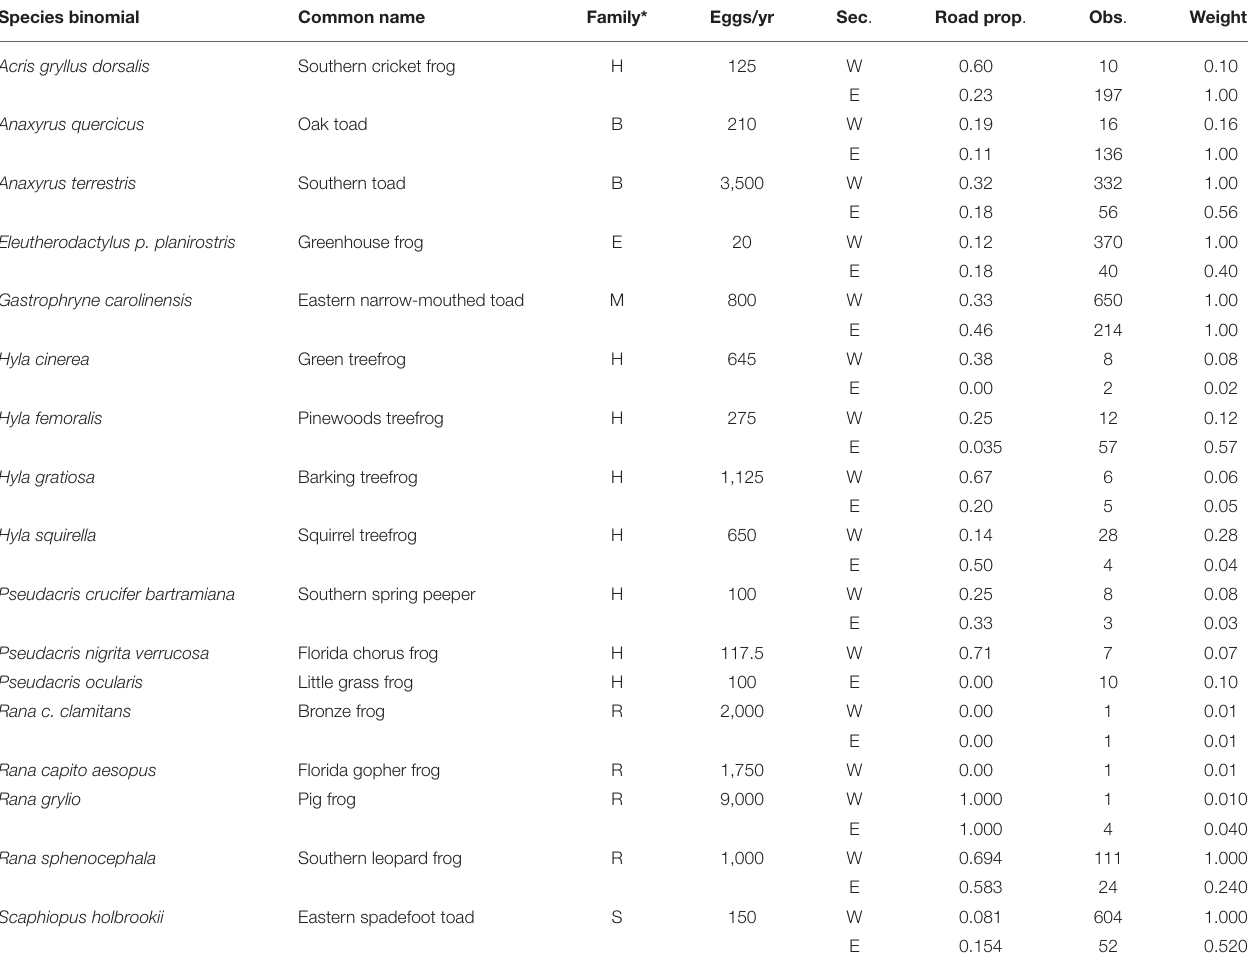
TABLE 1 | List of anuran species encountered in trap surveys. Species binomial Common name Family* Road prop